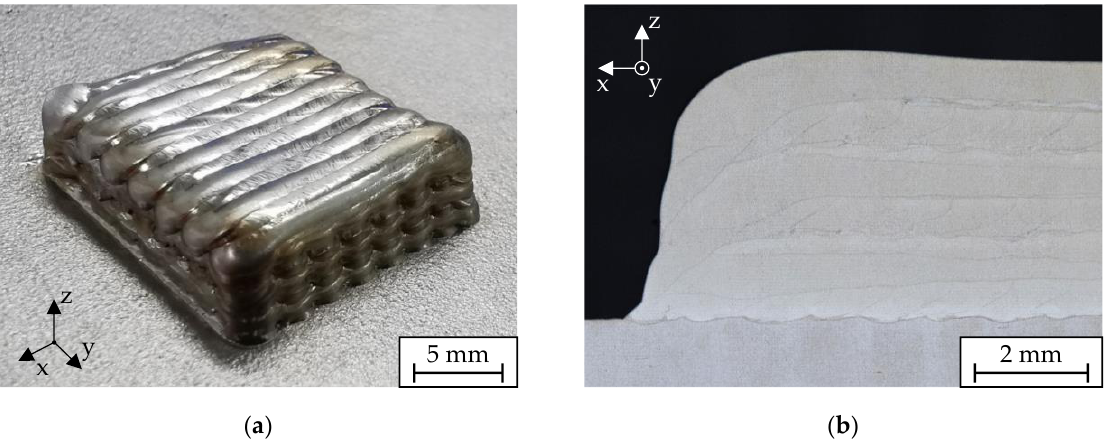
Figure 11. ( a ) Multi-track multi-layer cuboid deposited using the optimized shielding gas nozzle; ( b ) one half of a cross-section of the deposited cuboid.